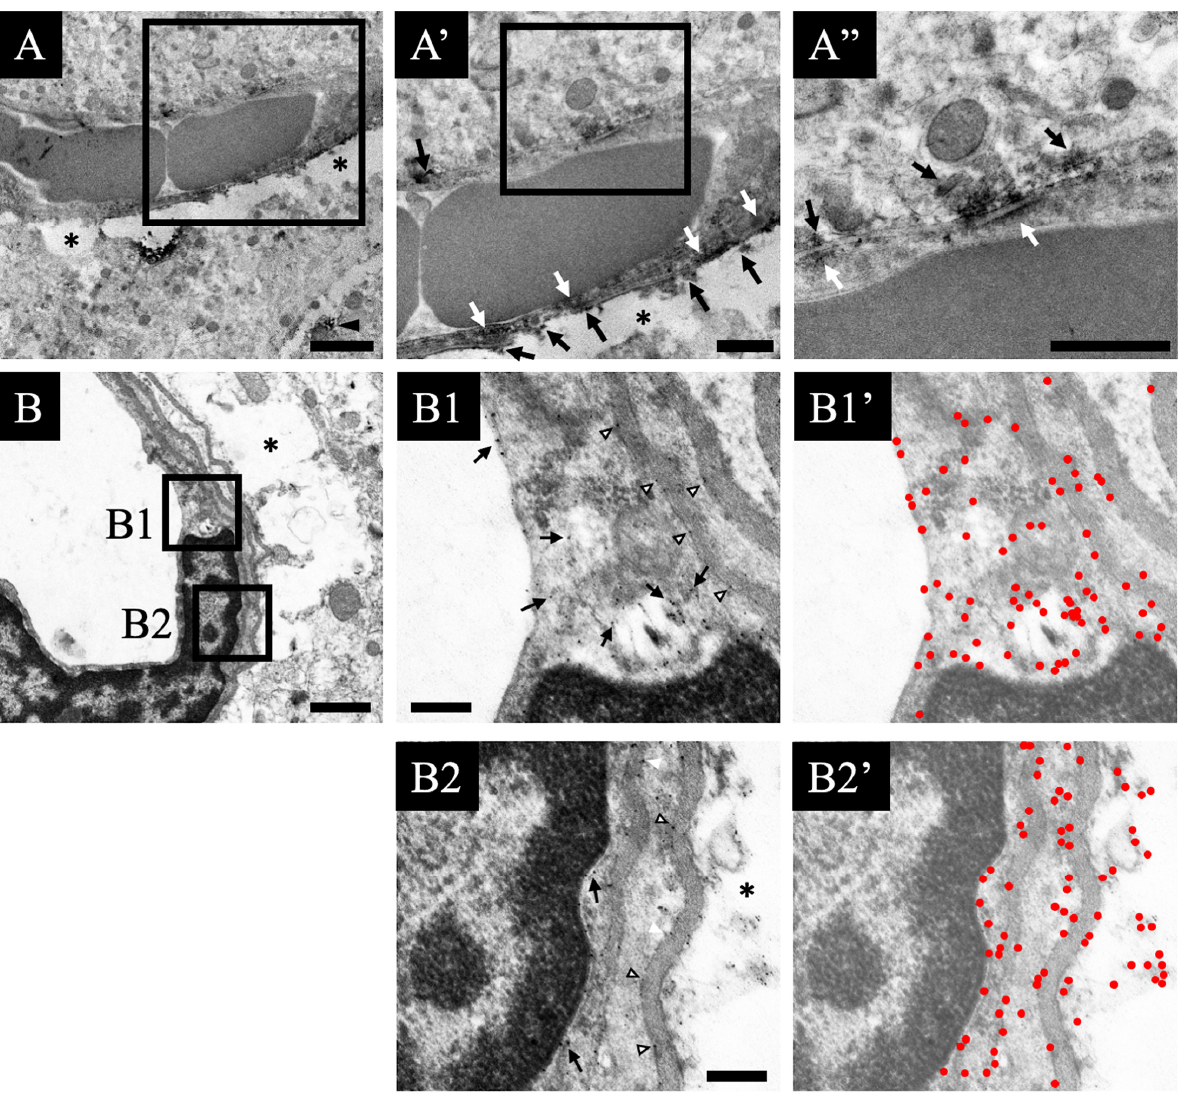
Figure 5. Immunoelectron microscopic images of the choline acetyltransferase staining sections of the aniracetam and α -GPC-treated animals are shown: ( A , B ) show the lower magnification views, ( A’ ) shows the middle magnification views, and ( A” , B1 , B2 ) show the higher magnification views. ( A – A” ) indicate the DAB-reacted hippocampal sections of the aniracetam and α -GPC-treated animals. Black arrowhead in ( A ) indicates the immuno-positive sites of the cholinergic axon. Black arrows in ( A’ , A” ) indicate the immuno-positive sites outside the basal membrane. White arrows in ( A’ , A” ) indicate the immuno-positive sites inside the basal membrane (blood vessel side). ( B , B1 , B1’ , B2 , B2’ ) show the gold particles in the hippocampal sections of the aniracetam and α -GPC-treated animals. Black arrows in ( B1 , B2 ) indicate the immuno-positive sites of blood vessels. White arrowheads in ( B1 , B2 ) indicate the immuno-positive sites on/near the basal membrane. In ( B1’ , B2’ ), the gold particles show the red circles. Black asterisks in Figure 4 show the swellings around the blood vessels. Scale bars in ( A , A’ , A” , B , B1 , B2 ) = 2 µ m, 1 µ m, 1 µ m, 1 µ m, 0.2 µ m, and 0.2 µ m,